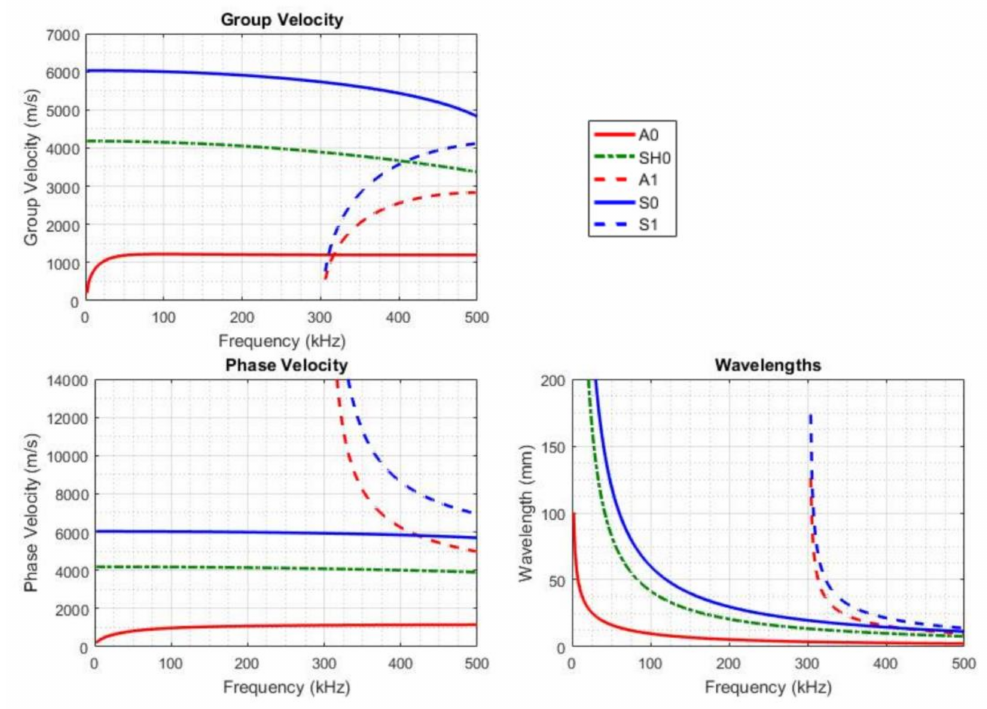
Figure 2. Theoretical dispersion curves for a quasi-isotropic CFRP plate (+45/ − 45/90/0/ −